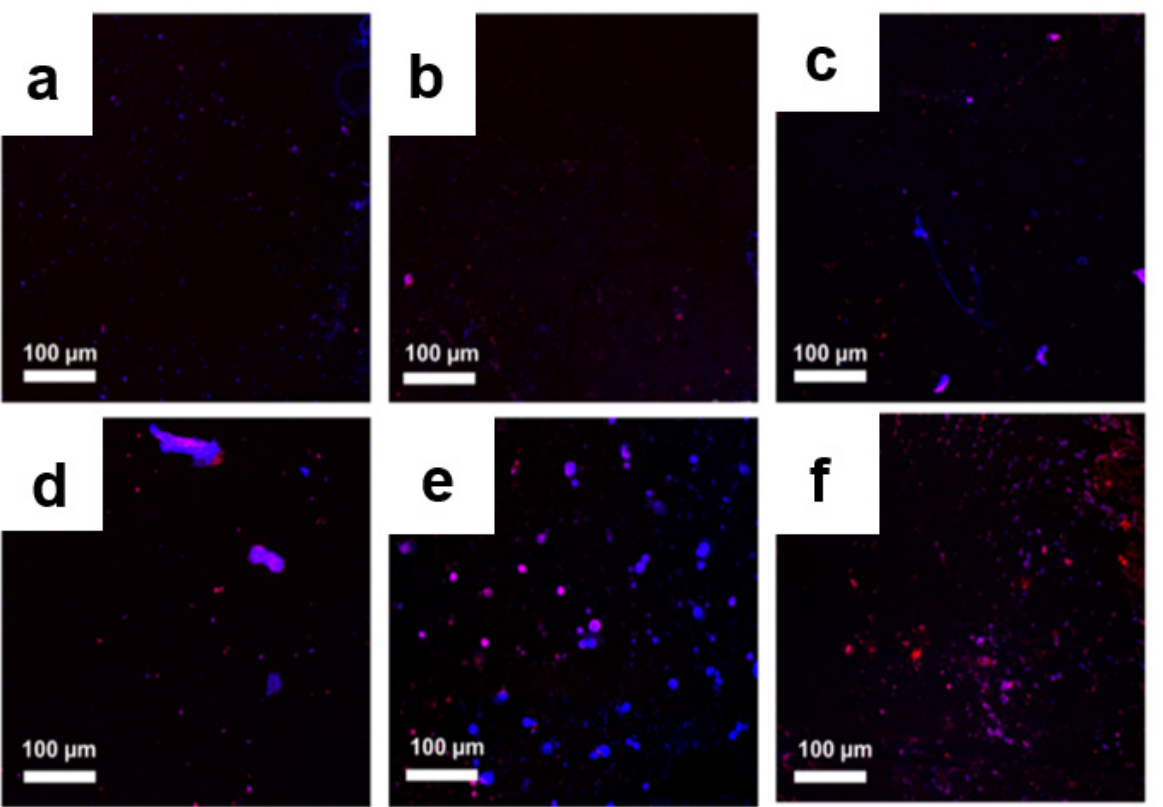
Figure 9. Confocal fluorescent images of control E. coli ( a ) and E. coli after treatment with GO ( b ), Ag NPs ( c ), Ag NPrsms ( d ), GO–Ag NPs ( e ), and GO–Ag NPrsms ( f ) stained with PI (red) and HS (blue).